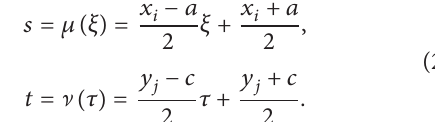
Table1:NumericalresultsofdifferentRBFsforExample 1.Theroots of Legendre polynomial are chosen as center